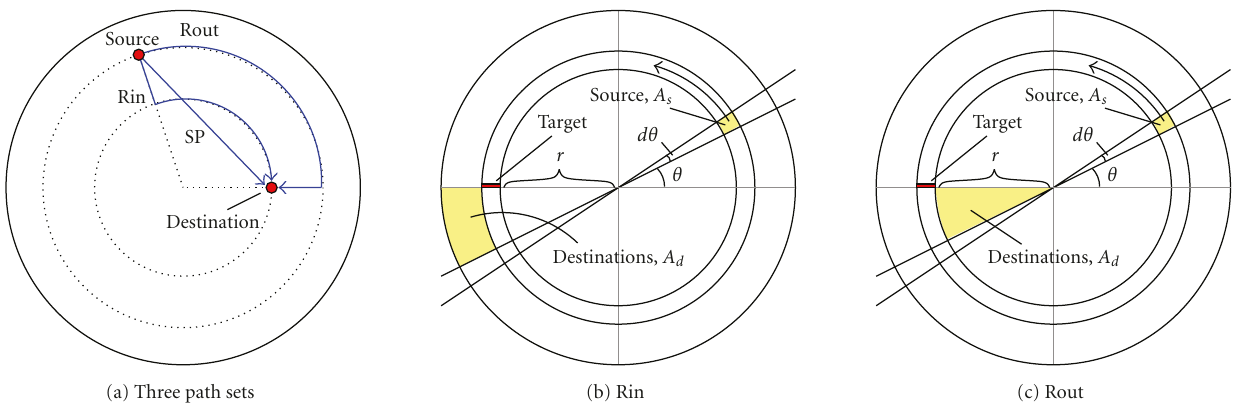
Figure 4: Radial ring paths. (a) illustrates the three path sets considered: straight line segments (SP), radial paths with outer (Rout) and inner (Rin) angular ring transitions. (b) illustrates the derivation of the angular ring flux at the distance r from the origin for Rin paths, and (c) for Rout